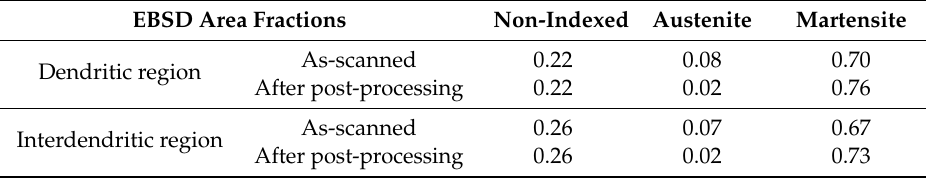
Table3. AreafractionsobtainedfordendriticandinterdendriticregionsbyEBSDanalysis. Areafractions obtained after data post-processing (by removing data points which had been wrongly indexed), is added. EBSD Area Fractions Non-Indexed Austenite Dendritic region